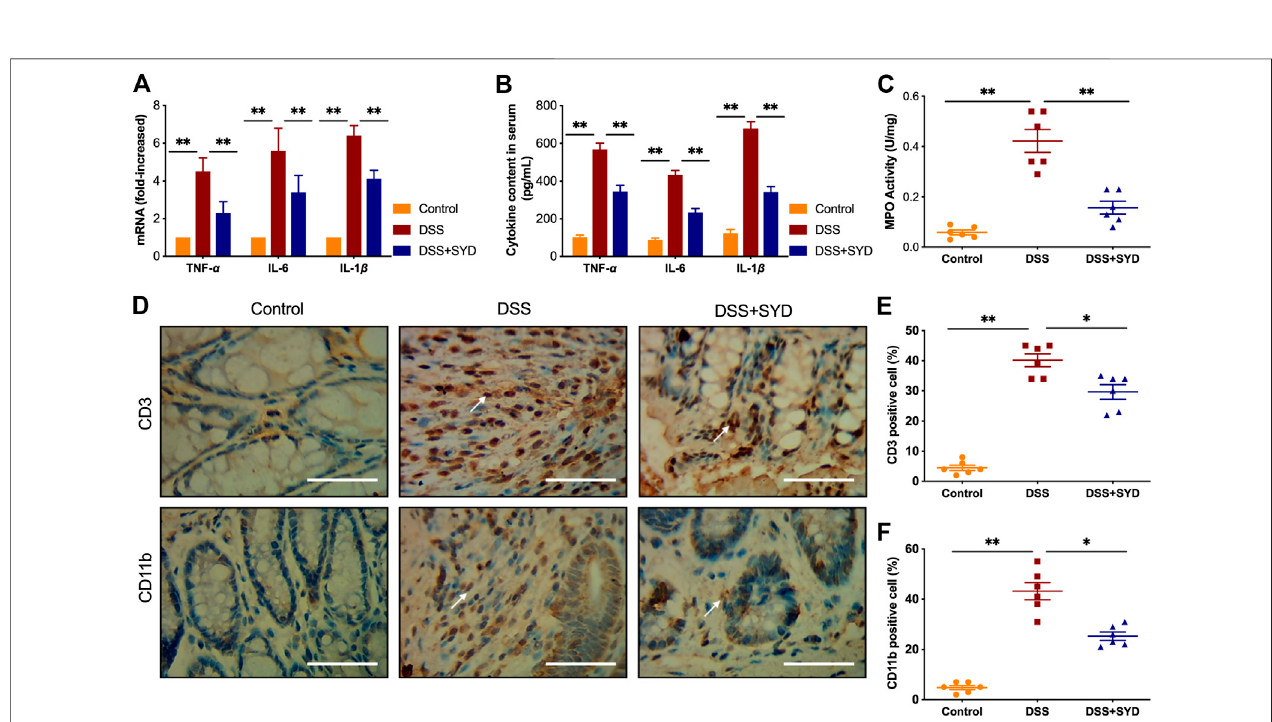
FIGURE3| SYDinhibitsproin fl ammatory mediatorsincolontissuesofDSS-inducedcolitismice (A) ThemRNAexpression of TNF- α ,IL-6,andIL-1 β incolonswas determined by real-time PCR (B) The protein levels of in fl ammation-related cytokines TNF- α , IL-6, and IL-1 β in serum were determined by ELISA (C) Colonic myeloperoxidase (MPO) activity analysis (D) Immunohistochemical analysis of T cells (CD3 + ) and macrophages (CD11 b + ) in colon sections. Scale bars (cid:2) 100 μ m (E, F) Quanti fi cationofCD3-positiveandCD11 b-positivecellpopulations wasperformedon fi ve fi eldsofviewpersection. Dataarepresented asthemean ± SEM,n (cid:2) 6 per group. * p < 0.05, ** p <